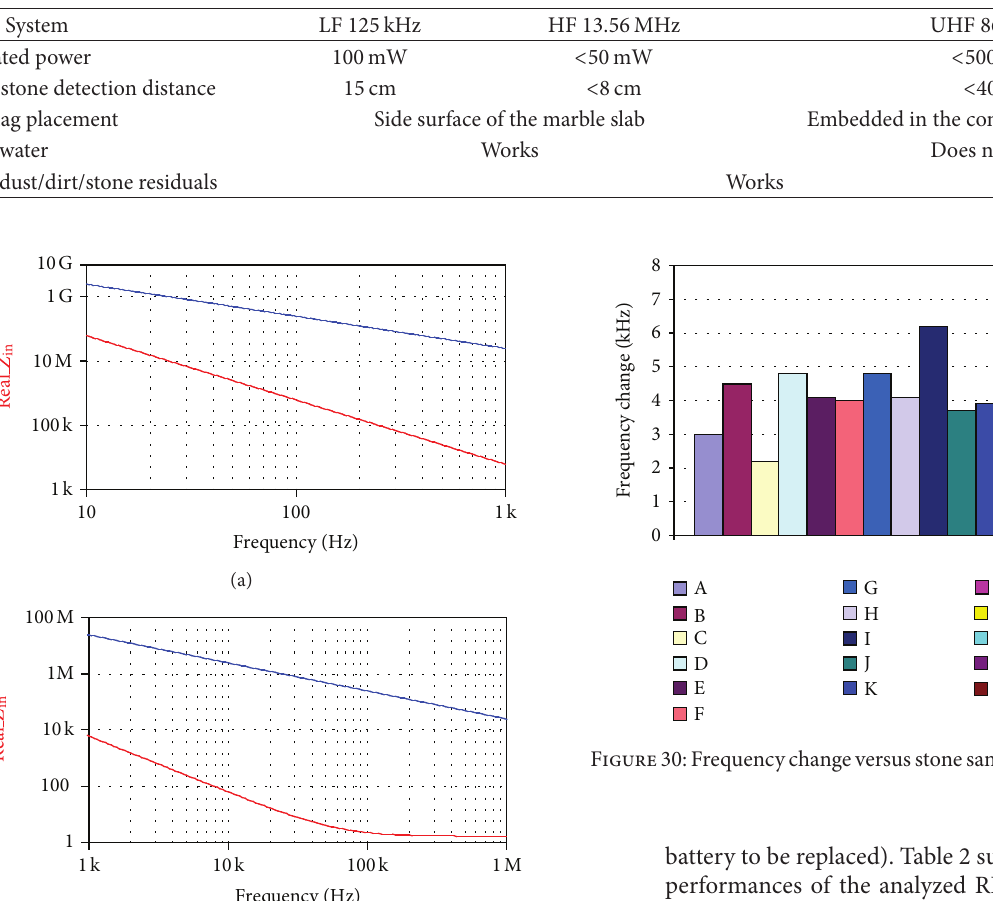
F 29: Real and imaginary (absolute value) parts of the surface capacitive sensor in Figure 28 (10Hz–1kHz and 1kHz–1MHz ranges) versus frequency.